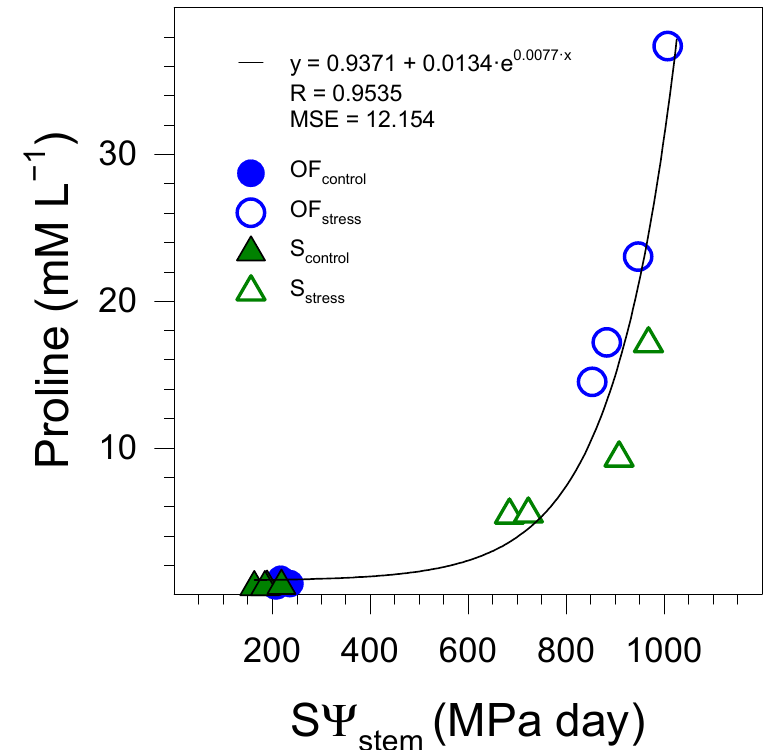
Figure 3. Relationship between proline content in lime juice and the accumulated water stress inte- gral (SΨ stem ) in control and stressed trees grown under open-field (OF control and OF stress , re- spectively) and shaded (S control and S stress , respectively) conditions. Each point corresponds to the individual value of each replication.